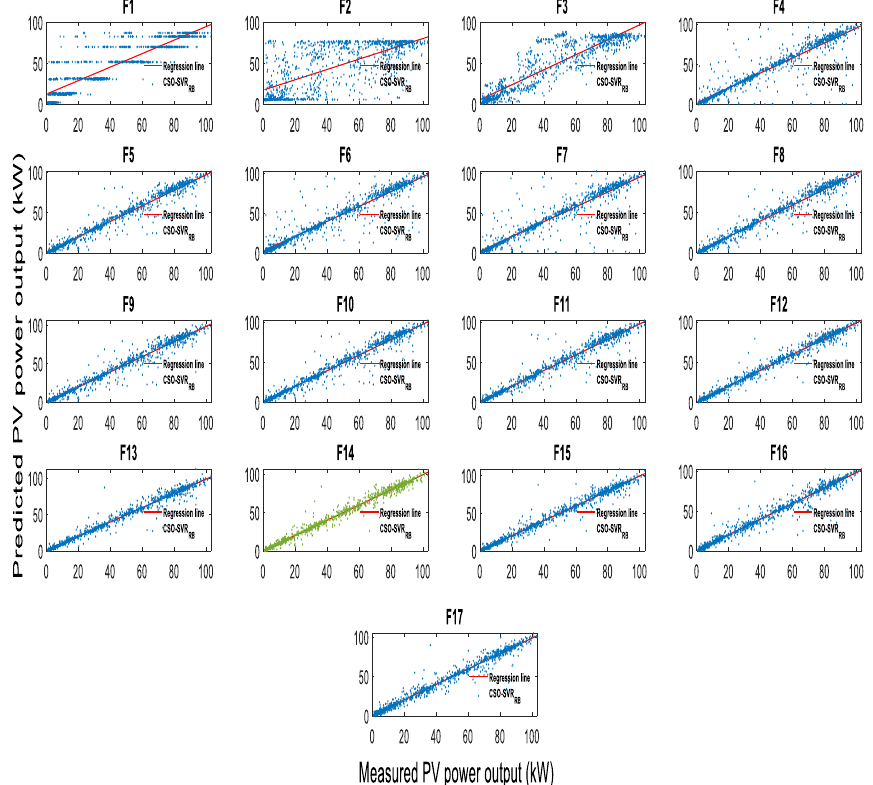
Fig. 12 Scatter plots of the measured vs. observed PV power output using SVR RB with CSO algorithms with all feature